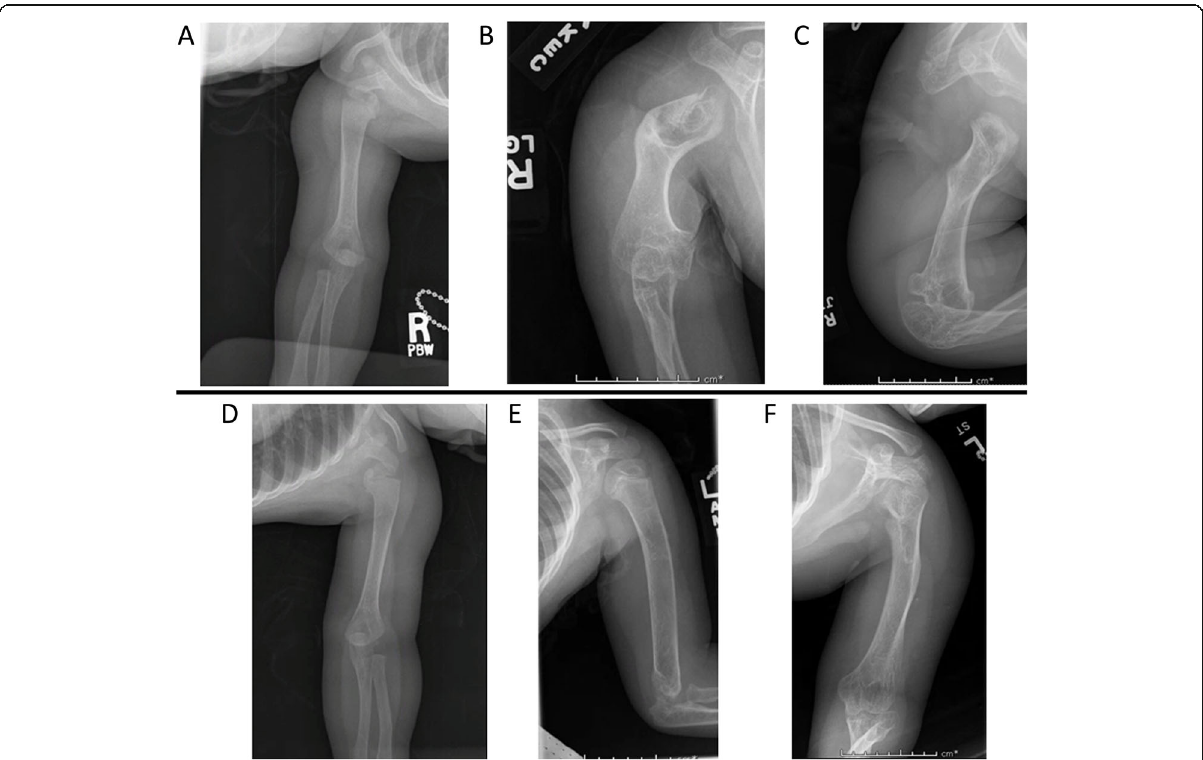
Fig. 5 a Right humerus film, 7 months. b: Right humerus film, 4 years 7 months. c: Right elbow fil, 11 years 7 months. d: Left humerus film, 7 months. e: Left elbow film, 3 years 7 months. f: Left humerus film, 10 years 7